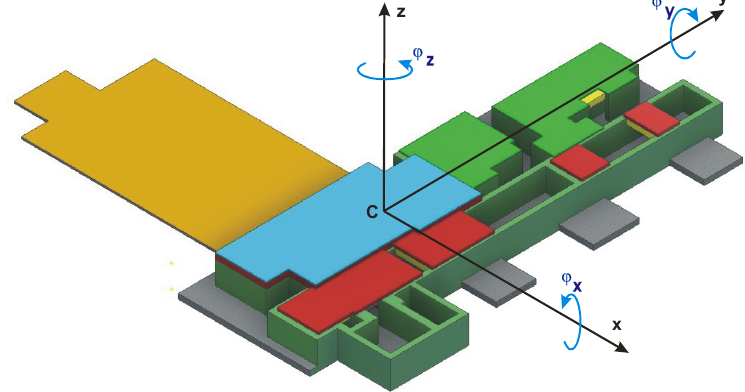
Figure 3. The inertial platform equipped with walls and roofs.